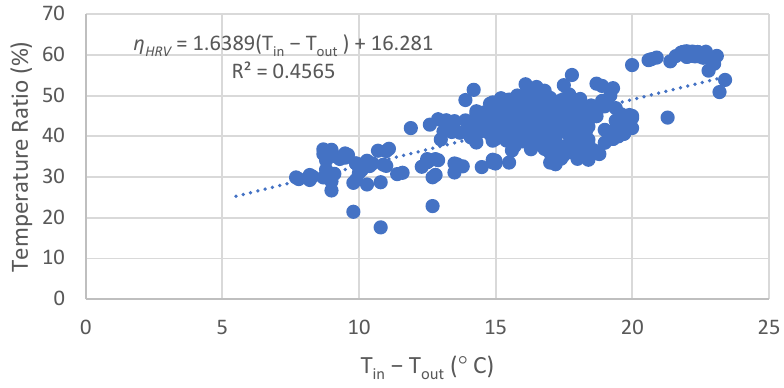
Figure 3. HRV temperature ratio based on indoor and outdoor temperatures.